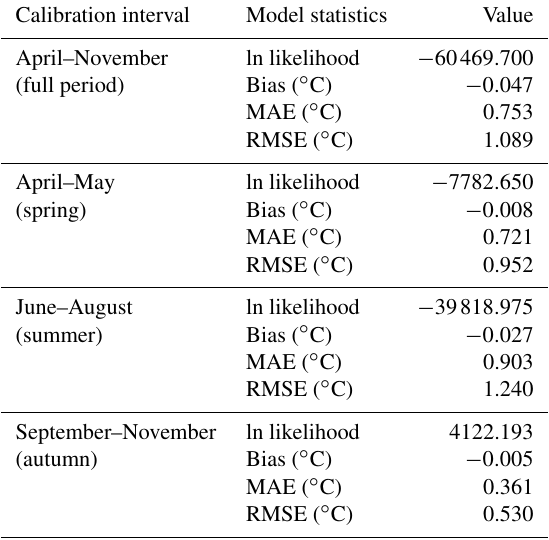
Table 3. Model performance over the entire calibration period (April–November) and different seasons (spring, summer,